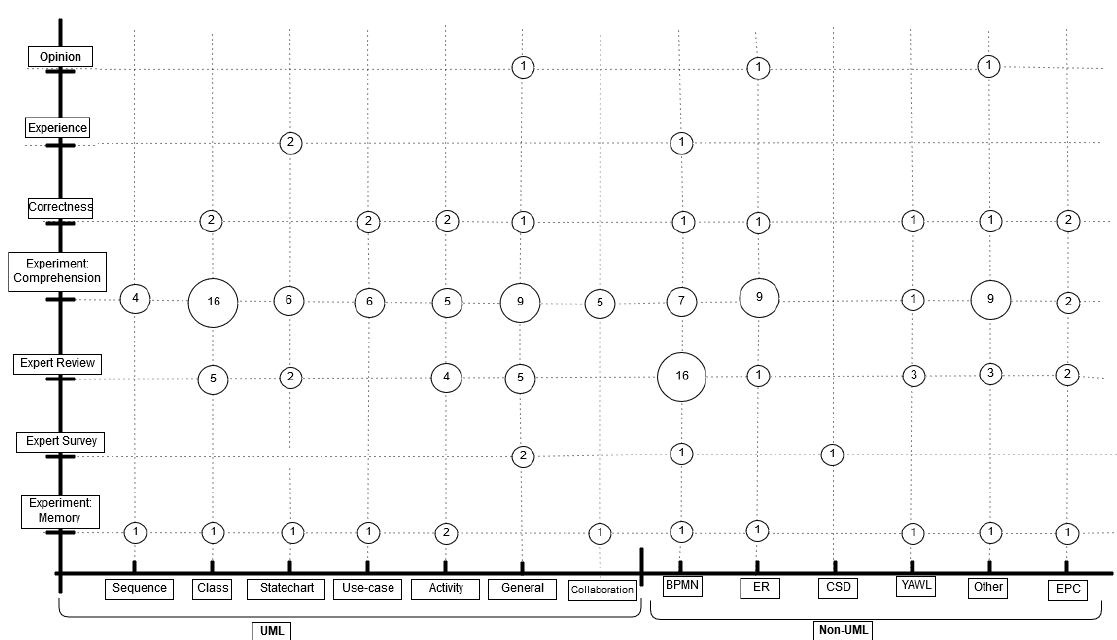
Figure 1. The number of papers found for each model type (divided between UML and non-UML